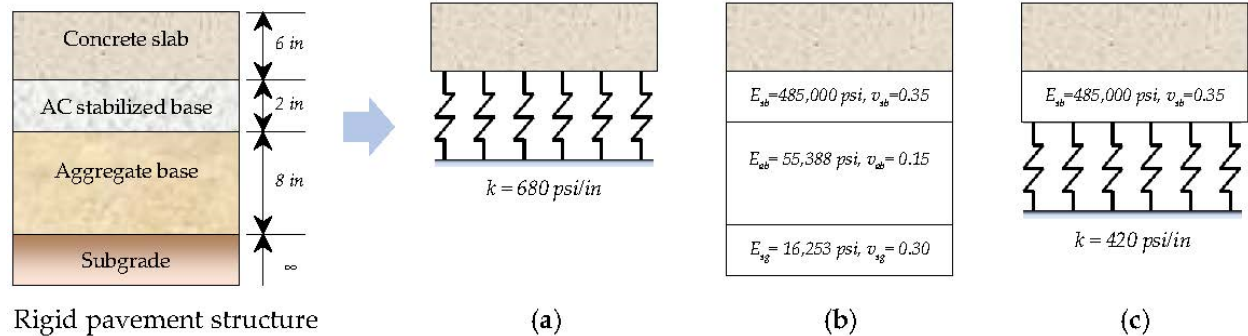
Figure 4. Three support models for rigid pavement system: ( a ) composite k -value model; ( b ) elastic-isotropic solid layered model; and ( c ) combined model (1 in = 25.4 mm, 1 psi/in = 271 kN/m 3 ).